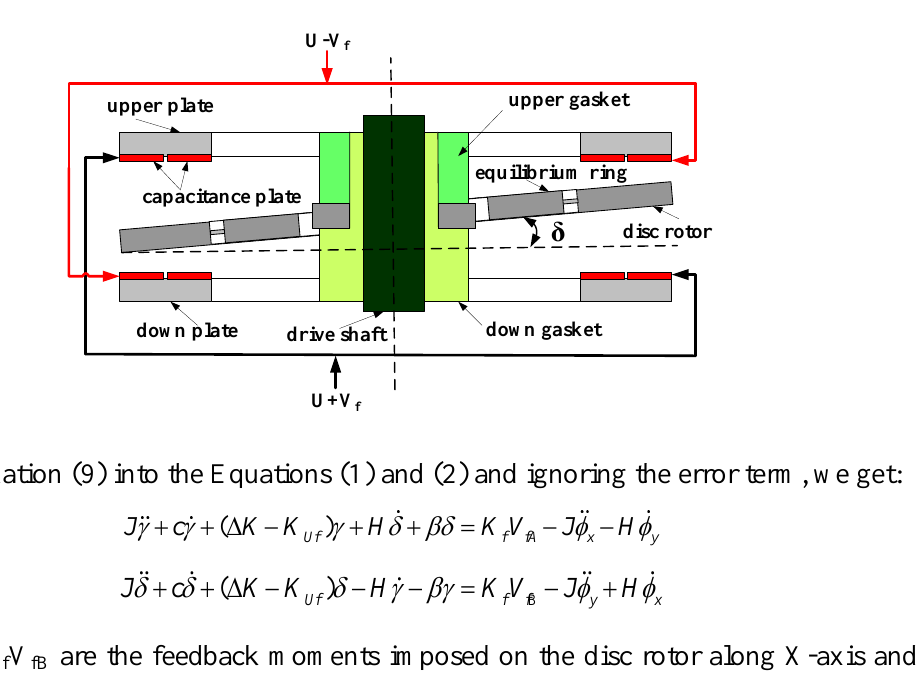
Figure 9. Schematic diagram of the tuning by negative stiffness.